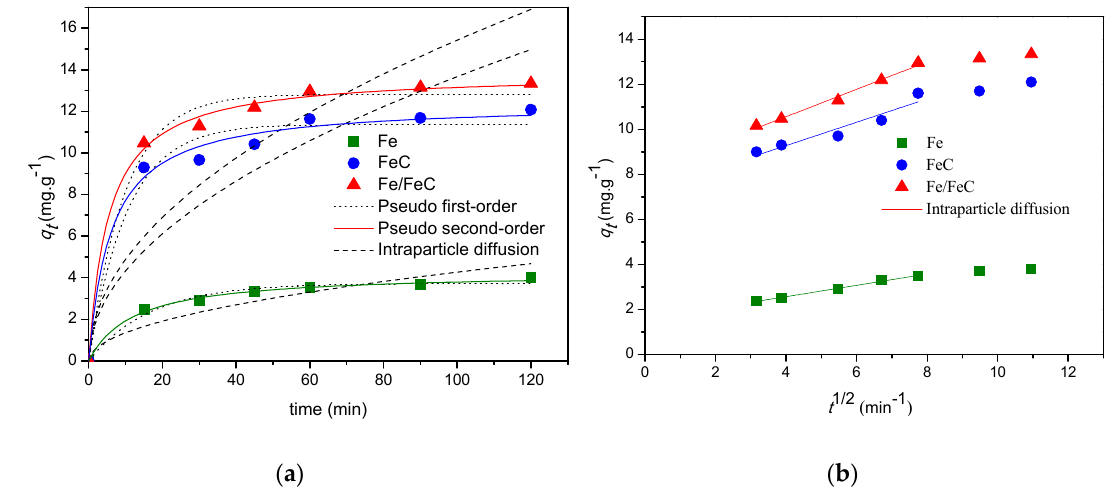
Figure 9. Kinetics analyses of the adsorption of Acid Red 66 on the solids studied: ( a ) Non-linear plots for pseudo1st order kinetics, pseudo 2nd order kinetics and intraparticle diffusion model. ( b ) Linear plot model for intraparticle diffusion. The initial concentration of the dye is 30 mg·L − 1 , pH = 6.8, T = 25 °C and dosage of the adsorbent of 2 g·L − 1 .